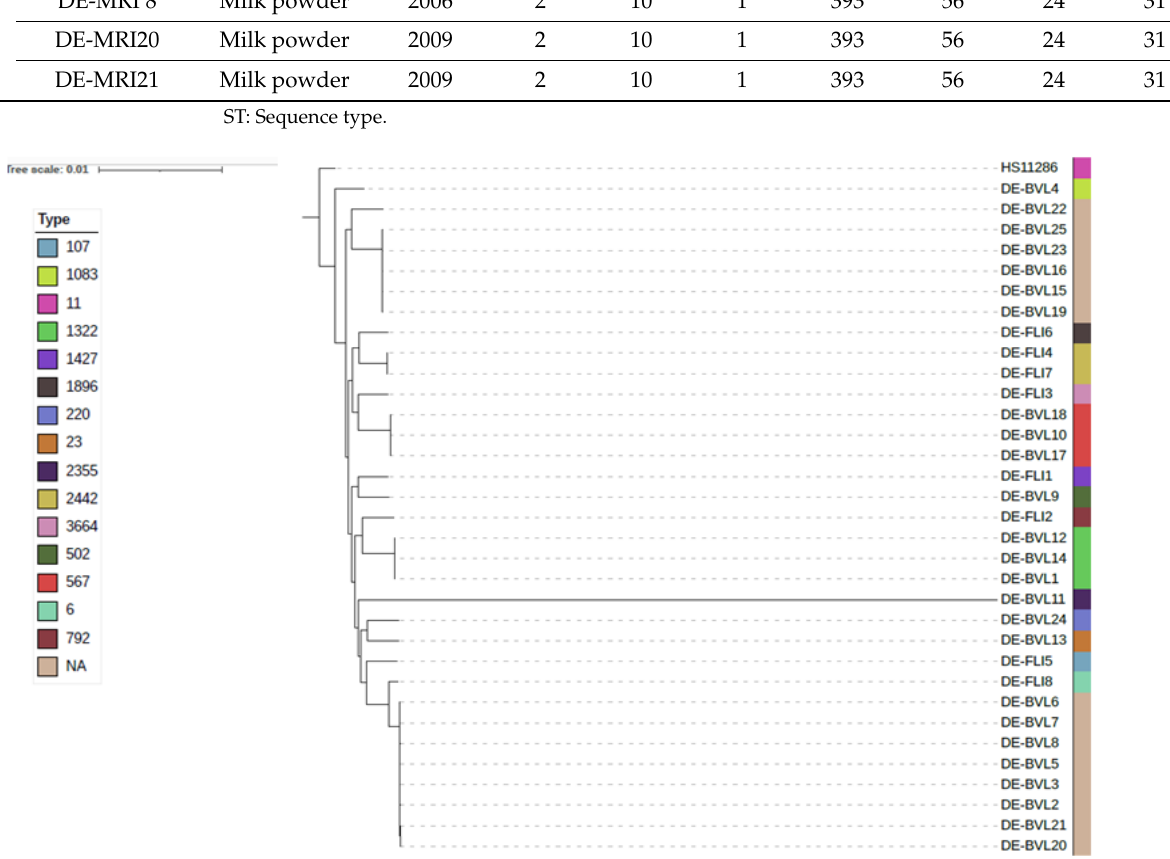
Figure 1. Phylogenetic tree using core-genome SNP of K. pneumoniae strains recovered from milk powder samples produced in Germany between 2005 – 2011.